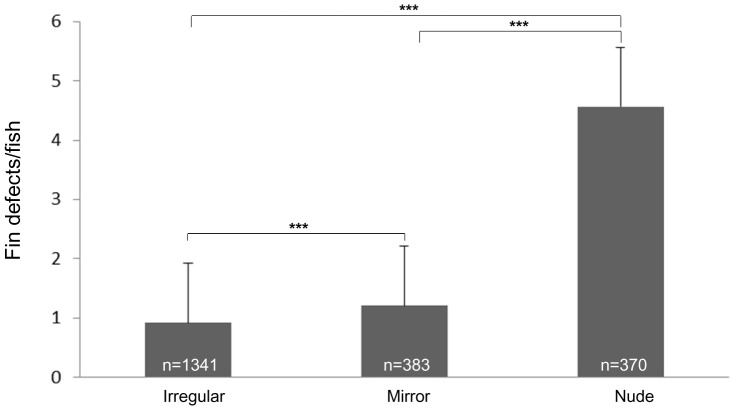
Association between the level of scale loss and fin defects in irregular, mirror and nude phenotypes across nine families.(A) Fin defects were quantified on a per fish basis using an arbirary scale (absence: 1 point, stunting: 0.75 point, reduction: 0.5 point and slight reduction: 0.25 point). The average of fin defects per fish are plotted for each group along with the standard deviation. *** indicates P-value (<0.005) calculated using Student's t-test. Numbers in white at the bottom of the bars indicate the number of individuals analyzed from each scale-pattern type.